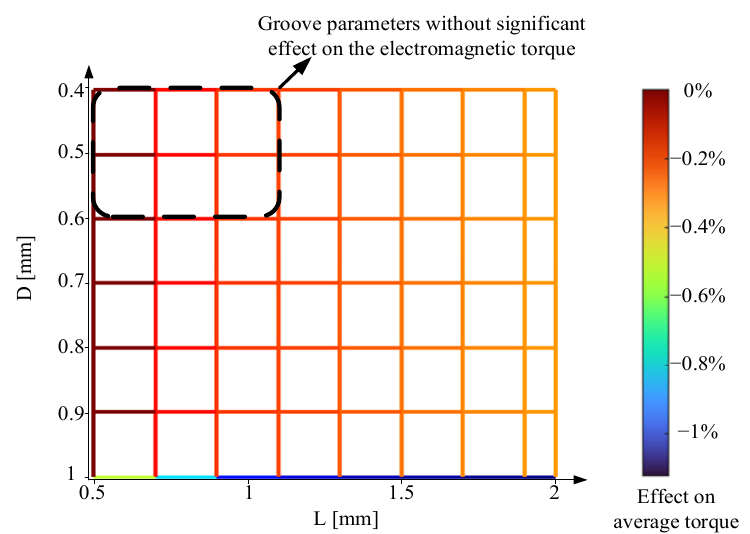
Figure 12. Effect of groove dimensions on torque production with 0.8 mm groove width.